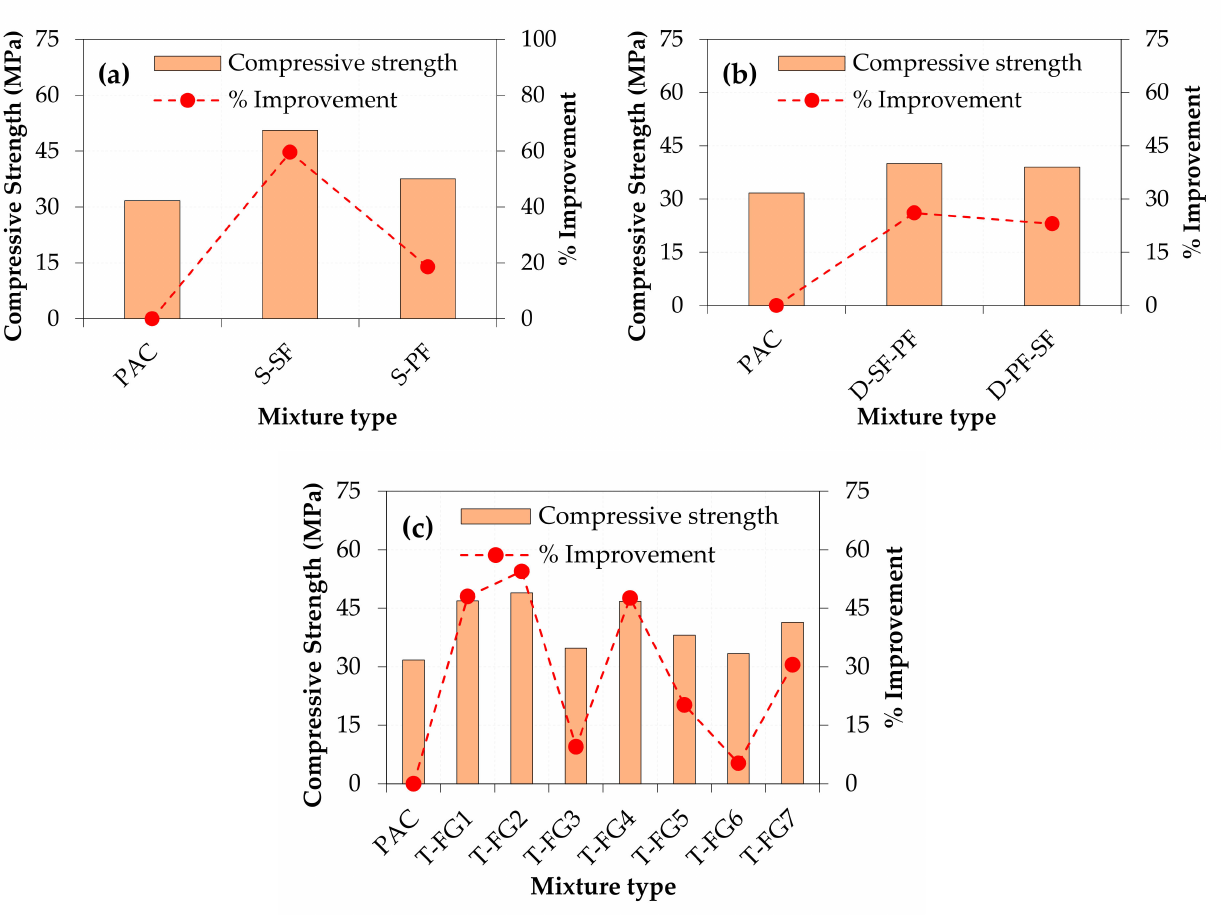
Figure 9. Observed compressive strength of FPAFC ( a ) Single layer, ( b ) Double layer, and ( c ) Triple